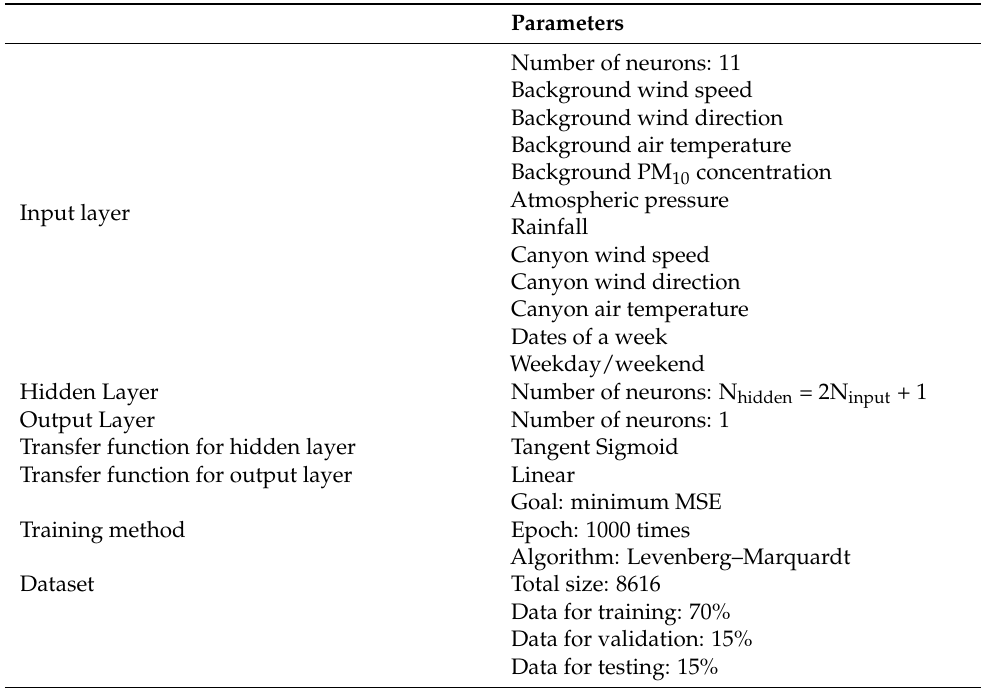
Table 1. The ANN model settings.